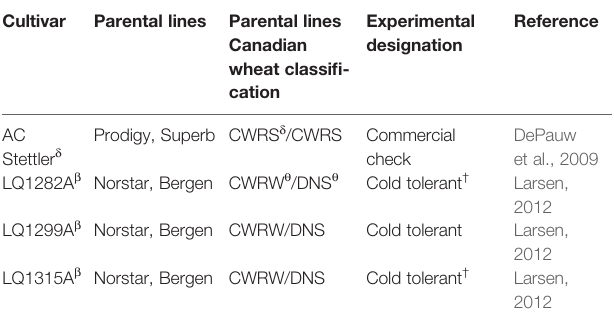
TABLE 2 | Classi fi cation of commercial check, cold tolerant, and parent lines.